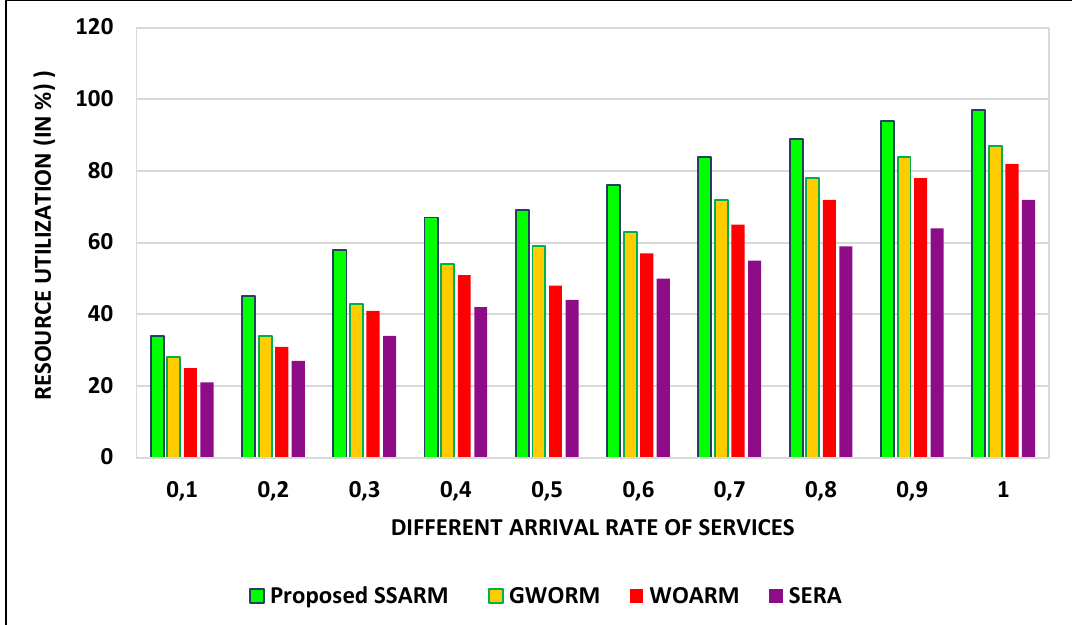
Figure 3. Proposed SSARM: Resource Utilization with Different Service Arrival